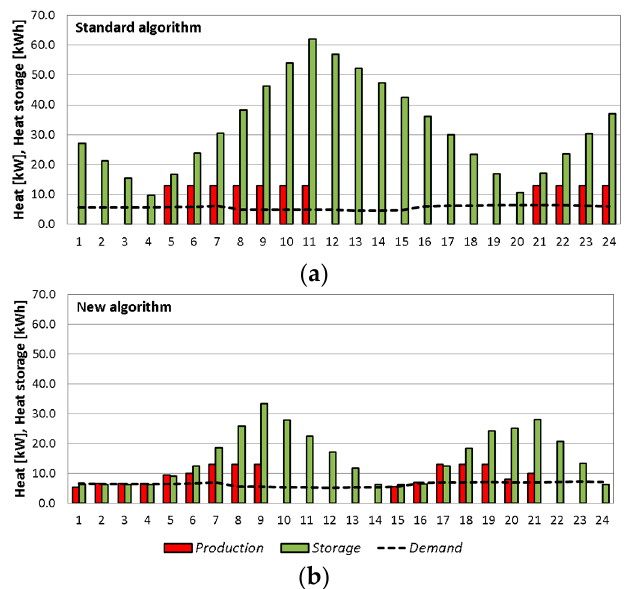
Figure 7. Profiles of the heat produced by the mCHP system (kW) and heat stored in the tank (kWh) with a capacity of 3 m 3 during the winter season, depending on the control algorithm used: ( a ) standard algorithm, and ( b ) new algorithm.